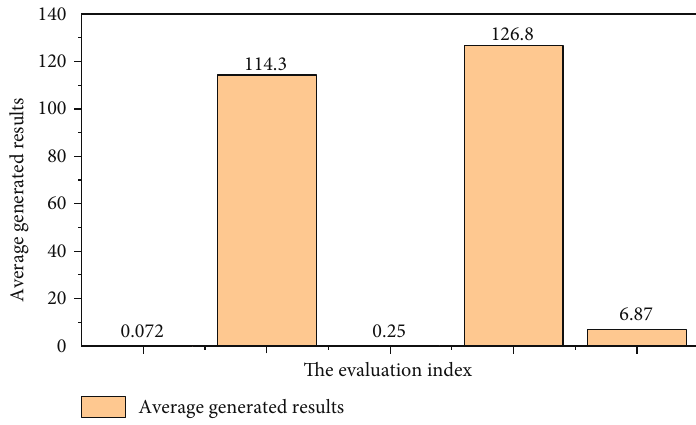
Figure 5: Performance comparison of real cases and generated results on the average value of generated